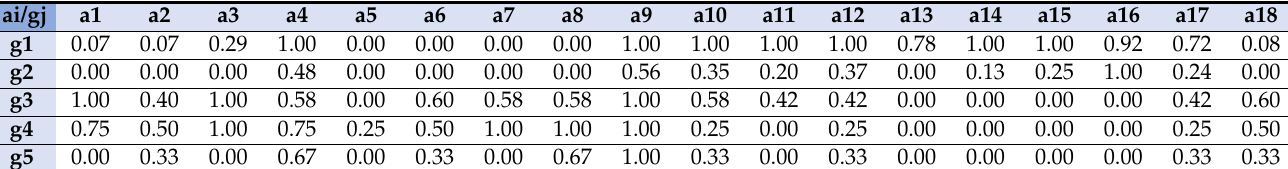
Table 12. Ranking of criteria